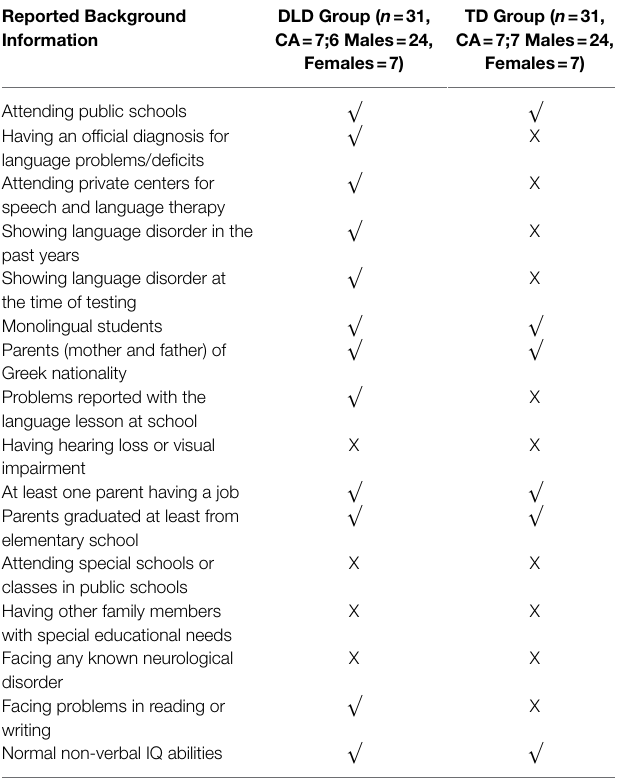
TABLE 1 | Demographic characteristics of the DLD and TD